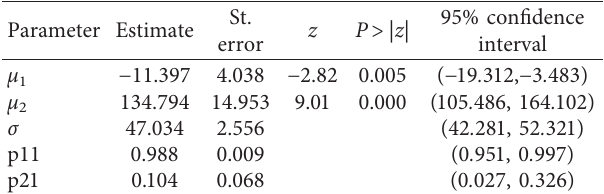
Table 4: Markov-switching regression in means only for the US BBB portfolio hedged by shorting UST bonds. Parameter Estimate